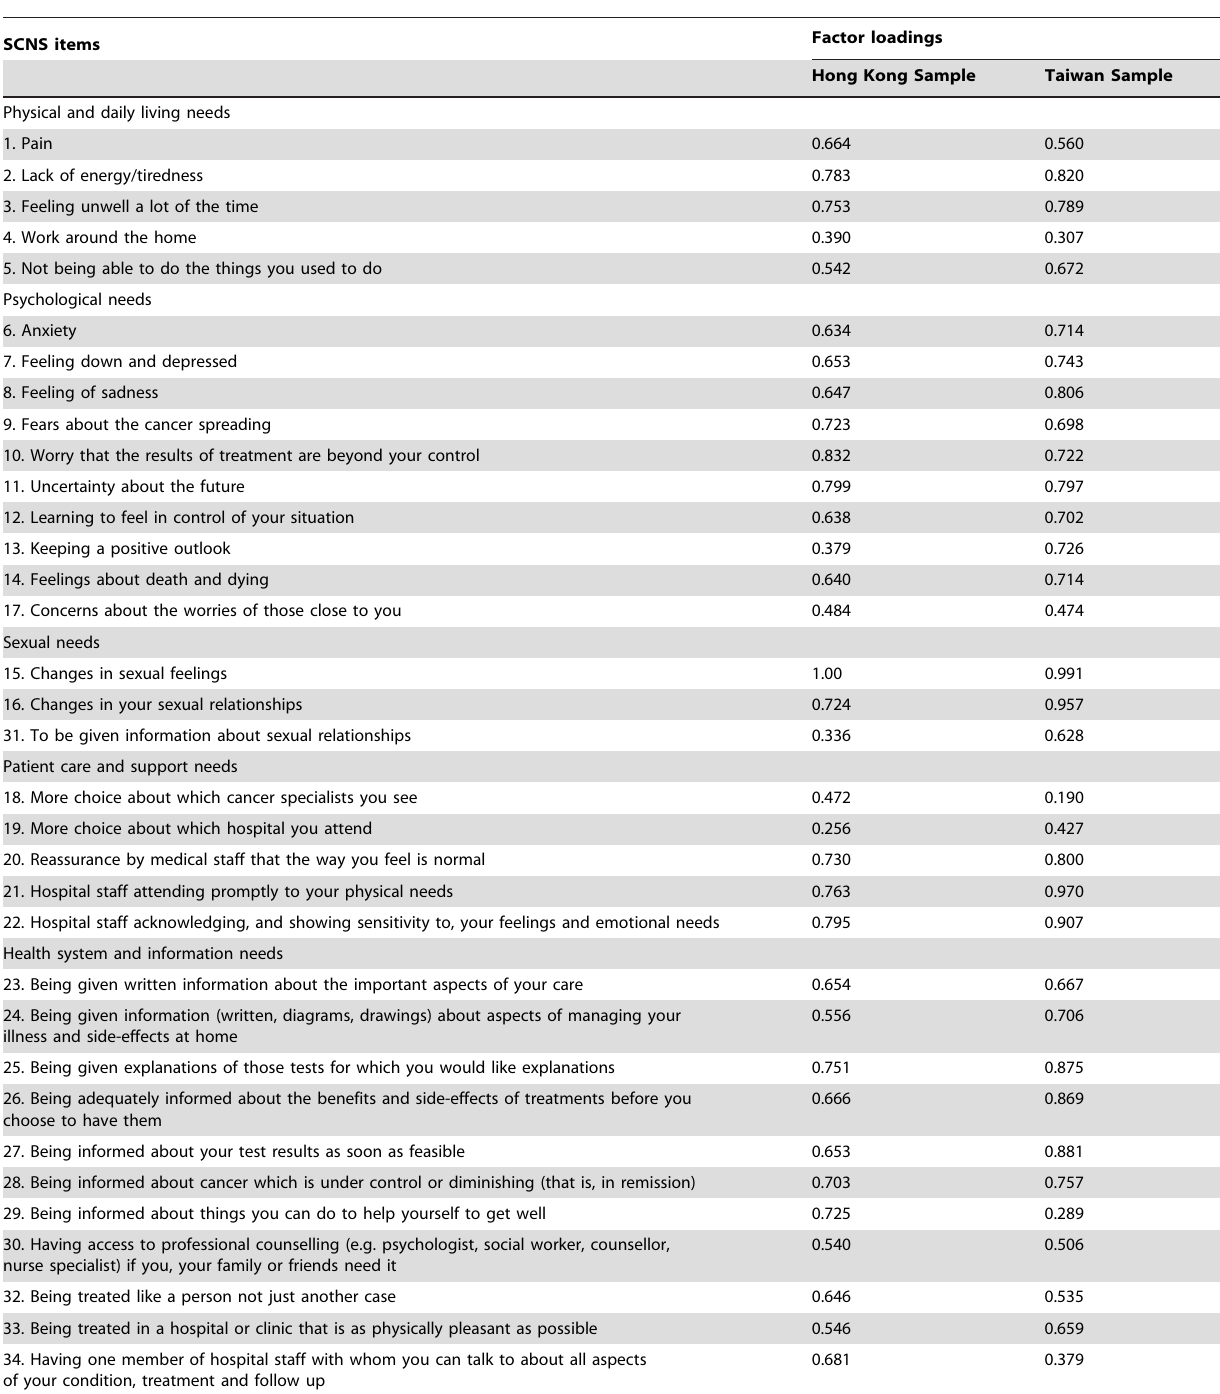
Table 3. Confirmatory factor analysis of modified SCNS-SF34 – factor loadings